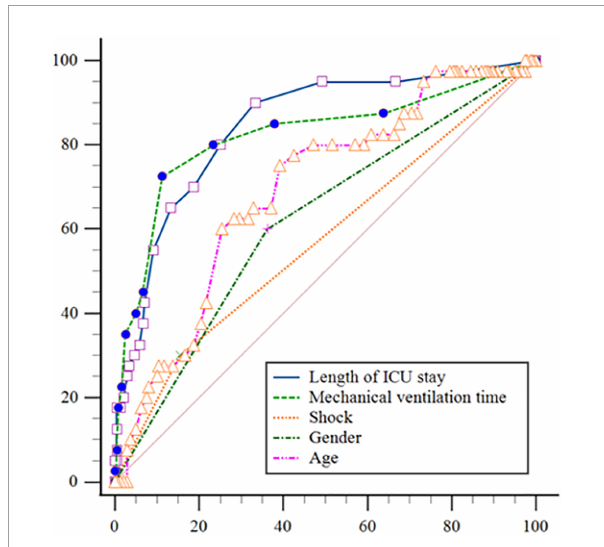
FIGURE6 Receiver operating characteristic (ROC) curves of each variable in the intensive care unit acquired weakness (ICU-AW) risk prediction model.